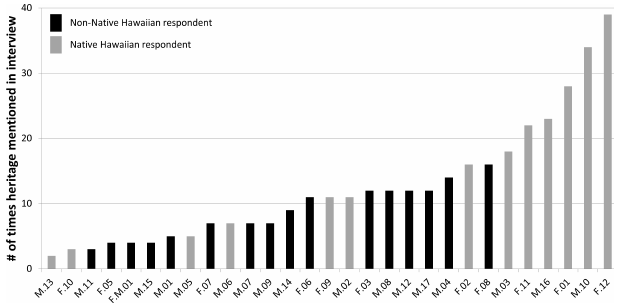
Fig. 3 . Number of times each respondent discussed